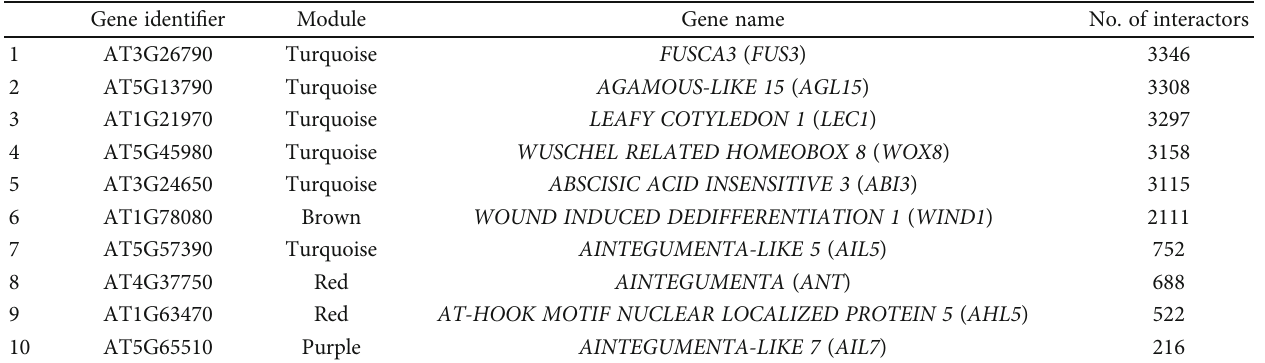
Table 4: Distribution of SE markers across network modules ordered by the number of